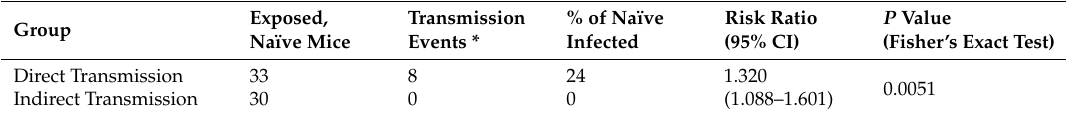
Table 1. Direct and indirect transmission of SNV in deer